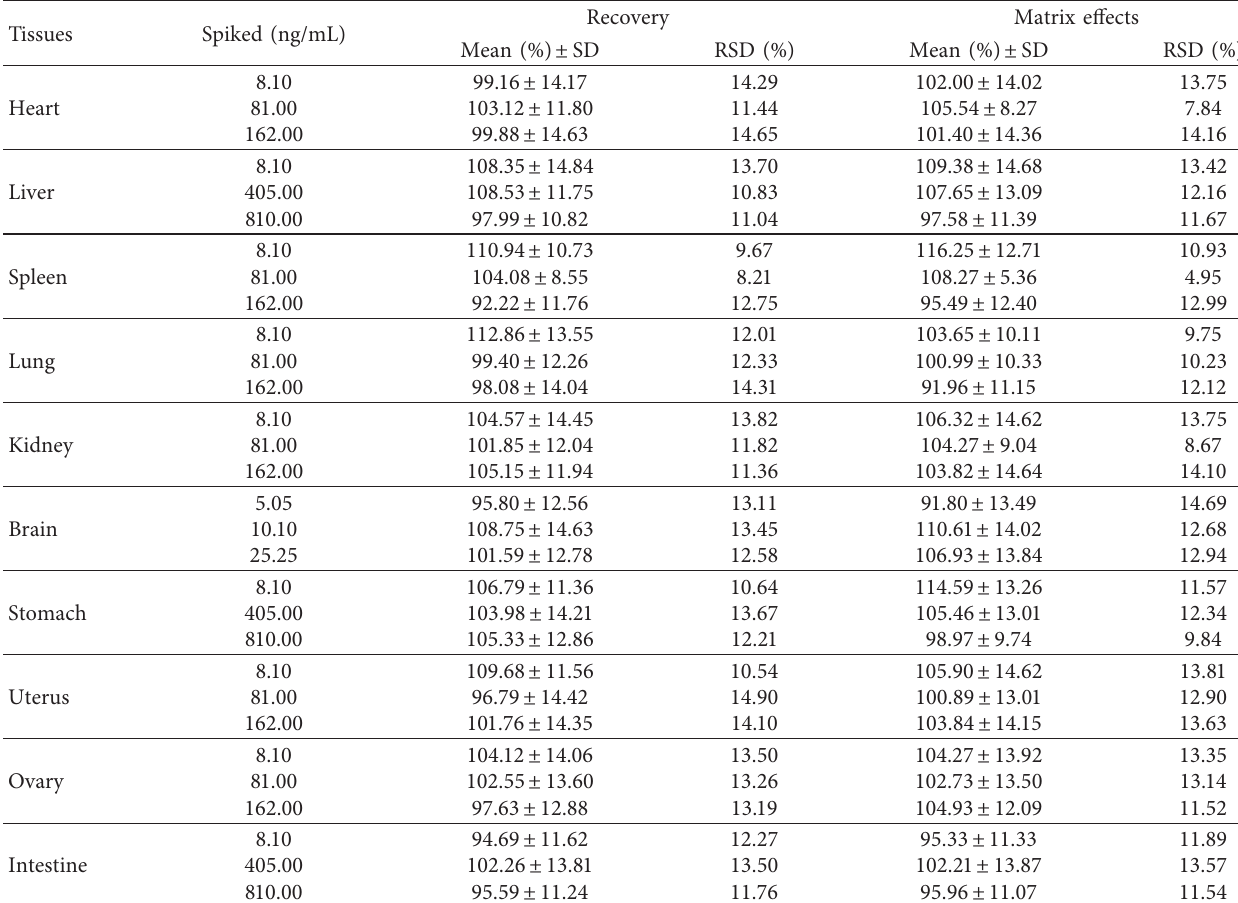
Table 15: Recovery and matrix effect study of naringenin in rat tissues ( n � 6).